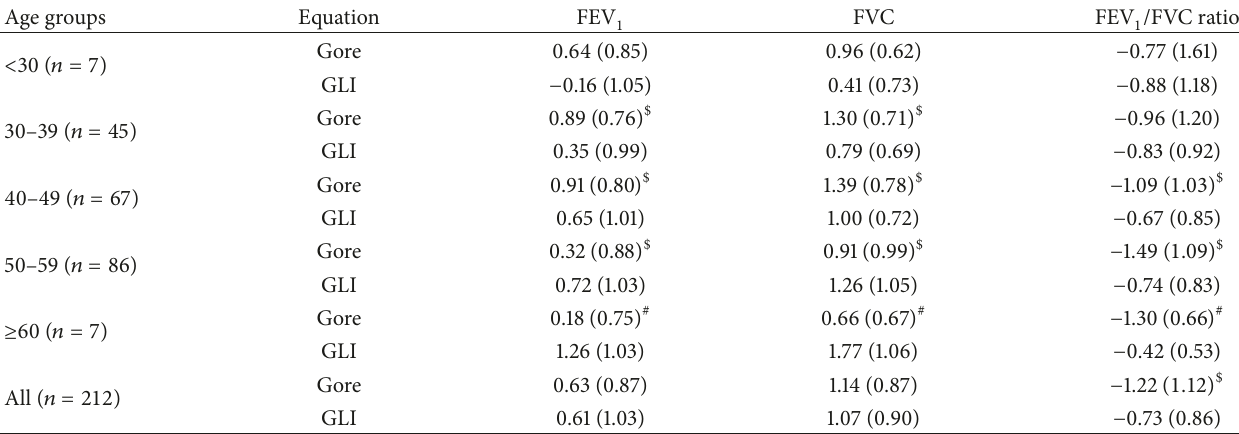
Table 2: Average 𝑧 -scores by age category. Participants are never-smokers with no history of doctor-confirmed asthma or lung disease. Values are mean (standard deviation) ( N = 212).